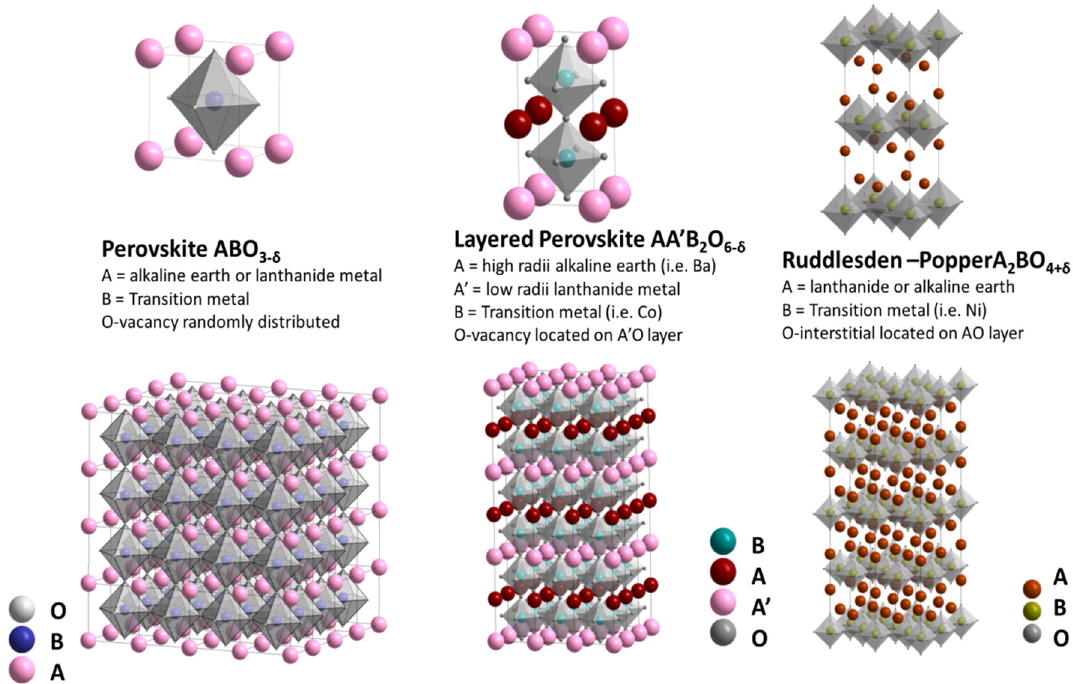
Figure 1. Crystal structures of perovskite, double perovskite, and Ruddlesden–Popper phase (Reproduced from [40] with permission from the Royal Society of Chemistry).